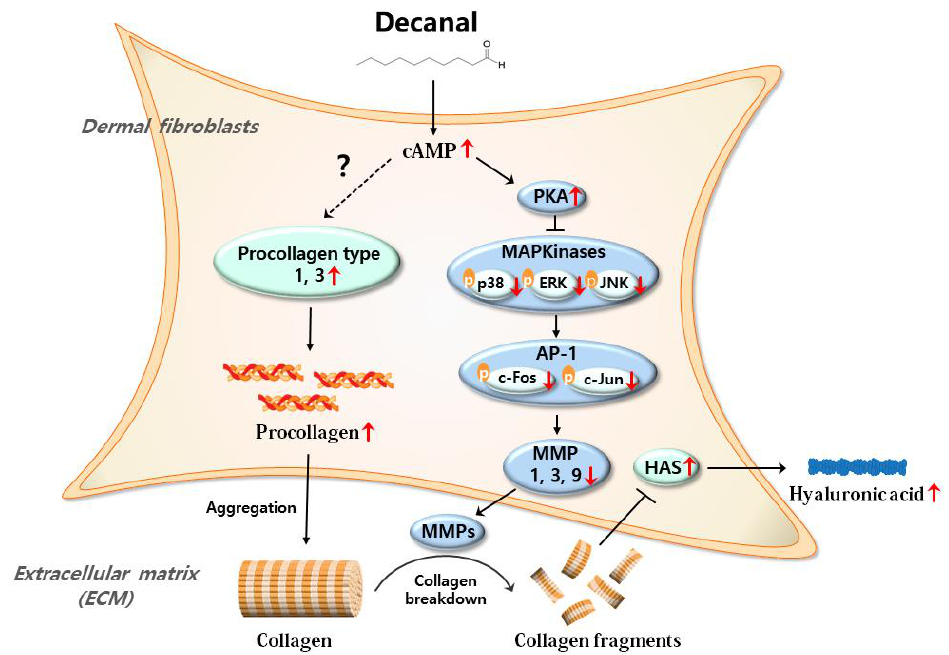
Figure 7. The proposed mechanism by which decanal protects photoaging in dermal fibroblasts. As depicted, higher production of cAMP in response to decanal increases the procollagen levels. The mechanism of cAMP-mediated procollagen production is not yet fully defined. On the other hand, cAMP production in response to decanal decreases the MMPs levels, with the possible involvement of the PKA/MAPK/AP-1 pathway. Then, collagen is less cleaved by decreased MMPs, resulting in increased hyaluronan synthase 2 (HAS2) gene expression and hyaluronic acid levels.